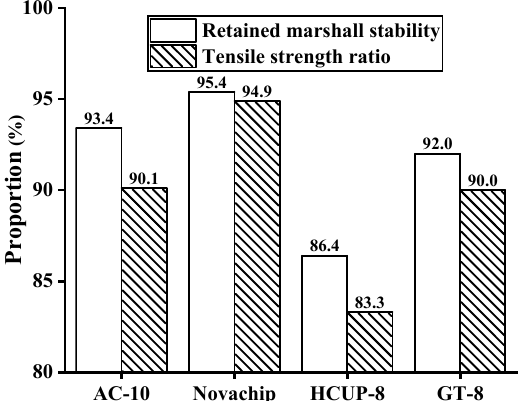
Figure 4. Results of Marshall stability and tensile strength. Table 8. Marshall stability test results.